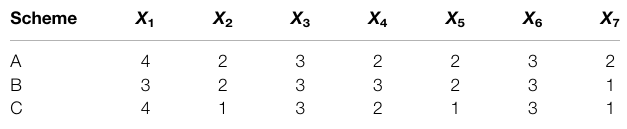
TABLE 5 | Parameter values of Schemes A, B, and C.